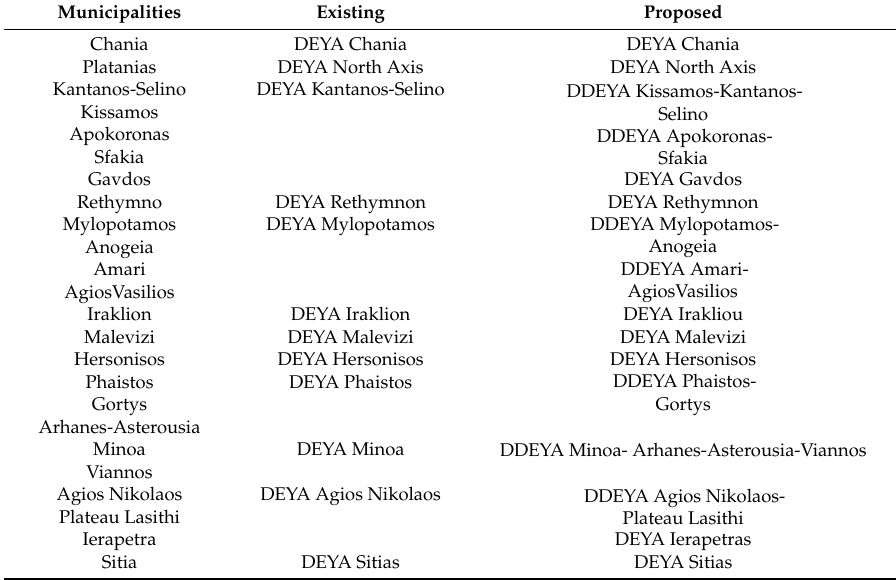
Figure 10. Municipalities in Crete. Table 10. The existing 24 Municipalities, the 12 Municipal Water Supply and Sewerage Enterprises (DEYA), the proposed 9 DEYA (including the existing ones), and the 7 Inter-Municipal Water Supply and Sewerage Enterprises (DDEYA).